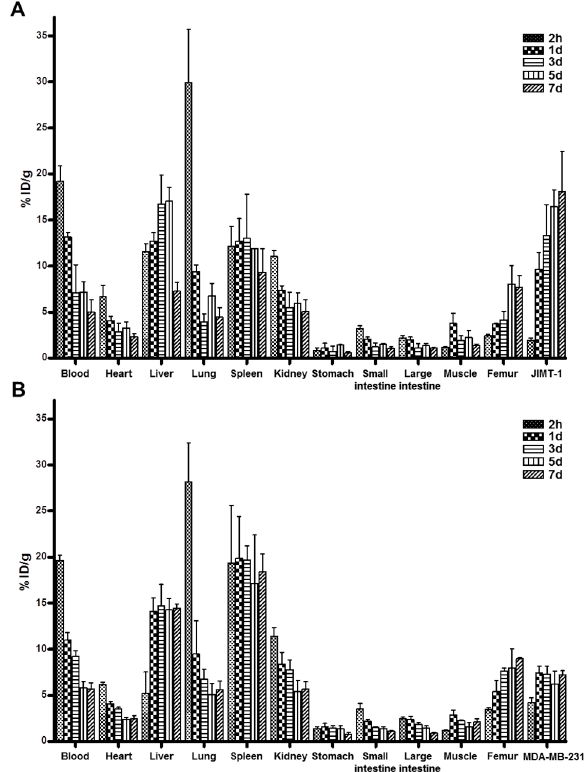
Figure 3. Biodistribution of 89 Zr-DFO-pertuzumab in HER2-positive (JIMT-1) and -negative (MDA-MB-231) breast cancer xenograft models. 89 Zr-DFO-pertuzumab (1.6~1.8 MBq/50 μ g/100 μ L) was injected intravenously into ( A ) HER2-positive (JIMT-1) and ( B ) negative (MDA-MB-231) breast cancer xenograft models. Biodistribution was performed at 2 h, 1 day, 3 days, 5 days, and 7 days post-injection of 89 Zr-DFO-pertuzumab, and the amount of radioactivity of collected blood, organs, and tumor represented as percentage of the injected radioactivity dose/gram (%ID/g) was determined. Data were presented as mean ± sd ( n = 3).